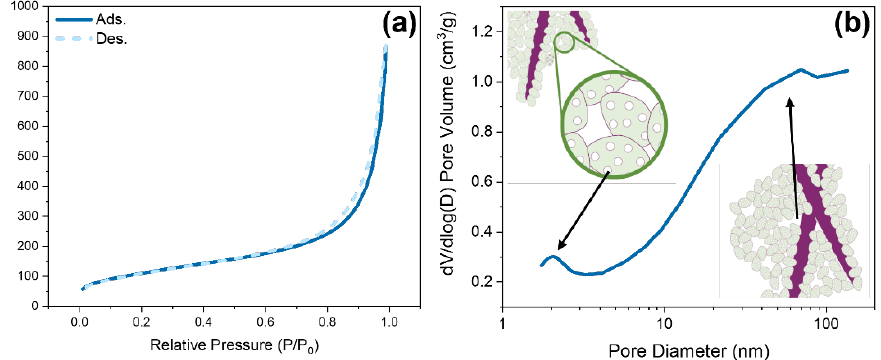
Figure 6. ( a ) N 2 adsorption – desorption isotherm; ( b ) BJH pore size distribution of the Mn- nanozyme. In the insets are included schematic representations of the intraparticle mesopores and the large interparticle